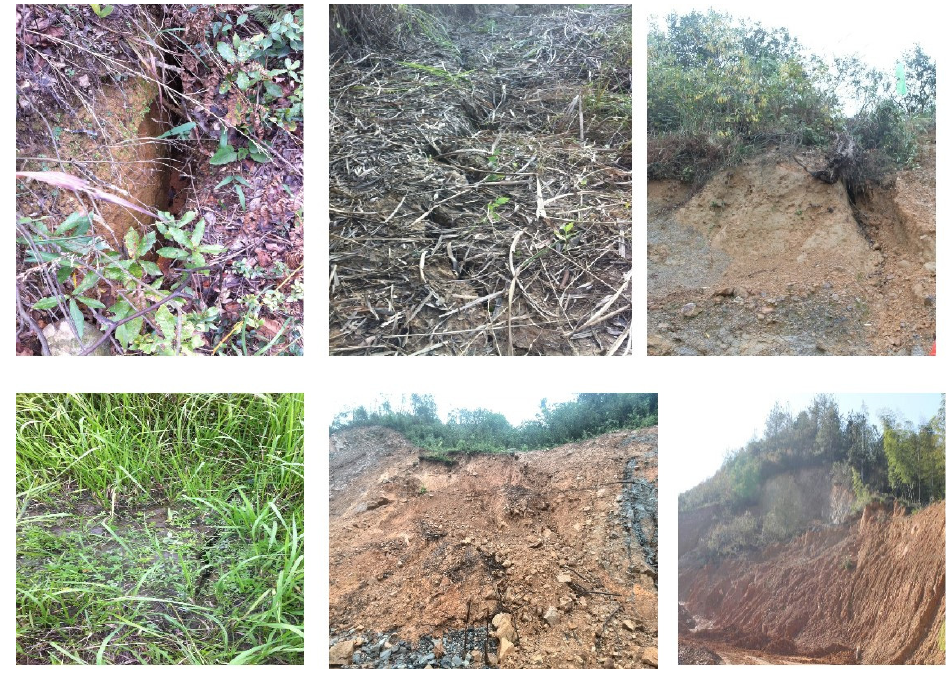
Figure 3. Overview of the project site.